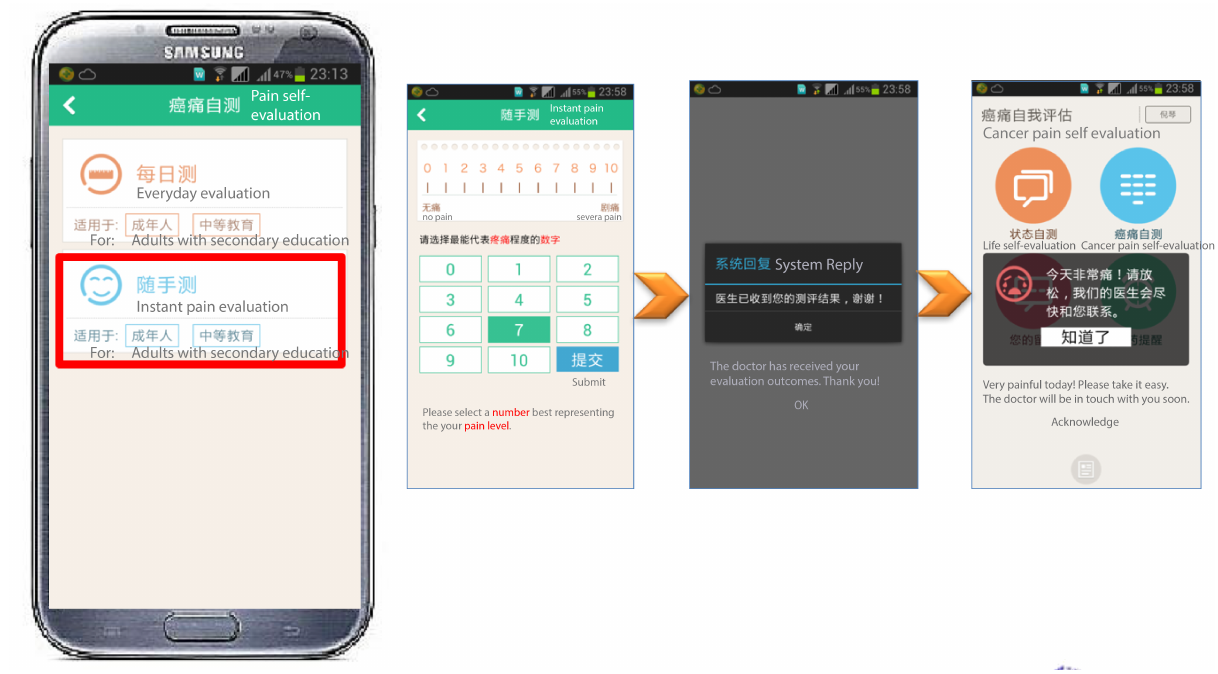
Figure 5. Screenshots of instant pain assess sub-module in cancer-pain self-evaluation